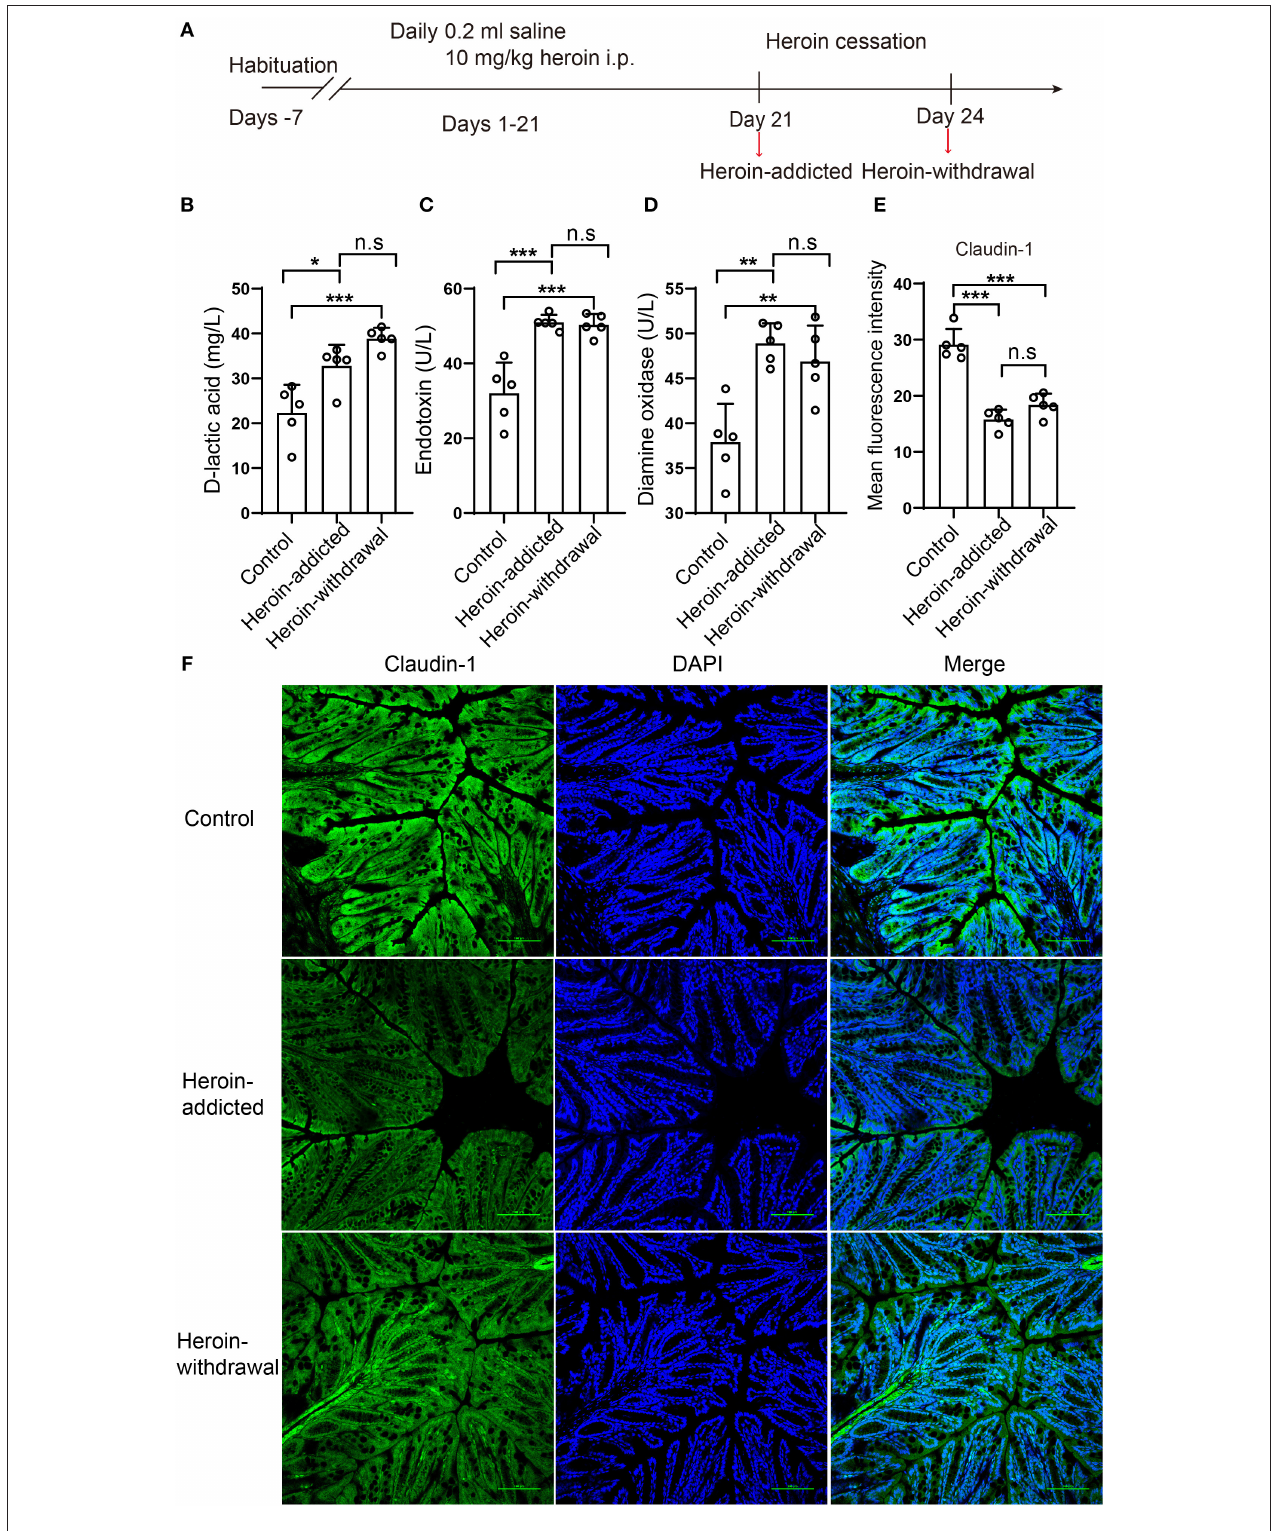
FIGURE 2 | Disrupted the intestinal mucosal integrity in mice with heroin dependence. (A) experimental design. The serum and colon tissues were collected on day 21 as heroin-addicted group, and after a 48-h withdrawal period (on day 24) as heroin-withdrawal group. (B–D) The serum levels of D-lactic acid (DLA), endotoxin (ET) and diamine oxidase (DAO) in heroin-addicted, heroin- withdrawal and control mice. (E) Immunofluorescence showed decreased expression levels of Claudin-1 in heroin-addicted and heroin-withdrawal groups. (F) Mean fluorescence intensity of Claudin-1 expression. All data are expressed as the mean ± SD * p < 0.05; ** p < 0.01; *** p < 0.001 ( n = 5 in each group).